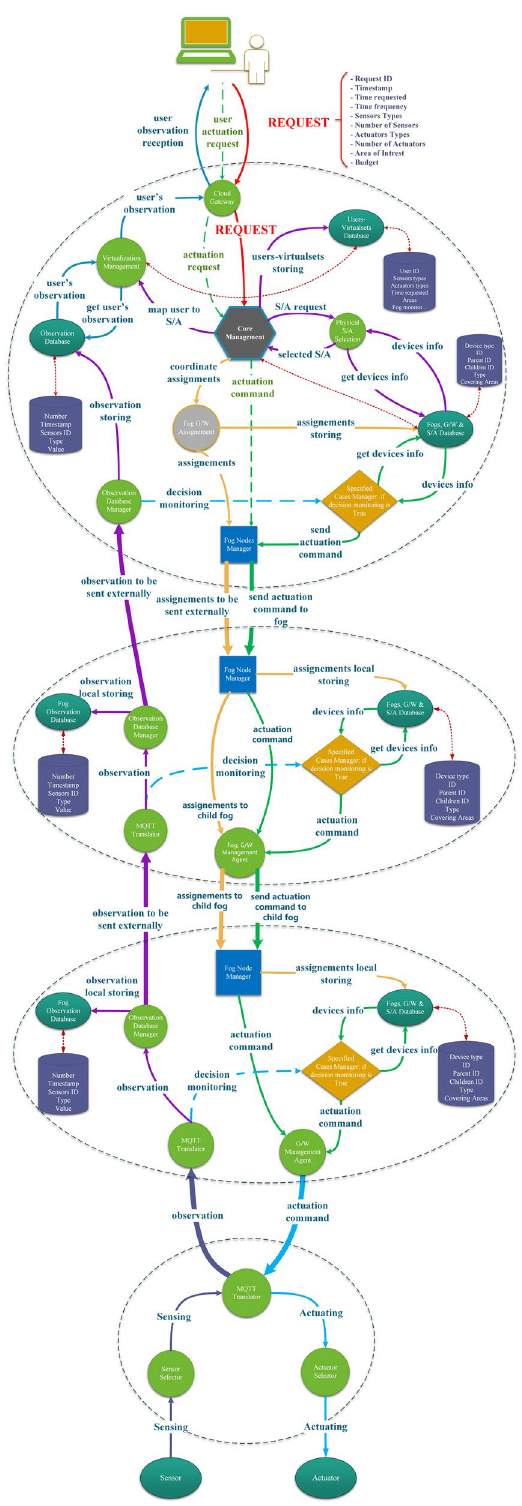
Figure 19. Communication among the cloud, parent fog, child fog, and